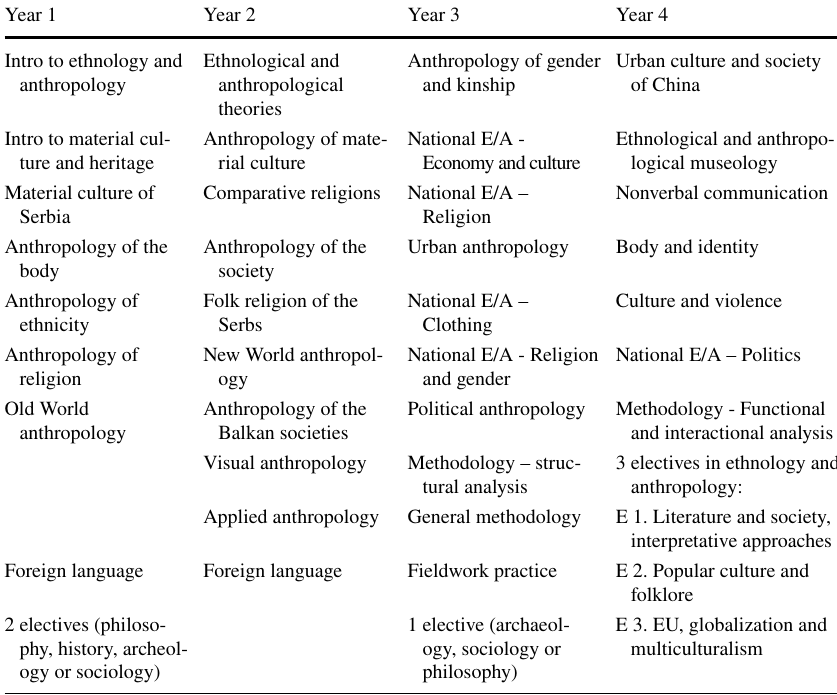
Table 1 Curriculum for a four- year undergraduate program